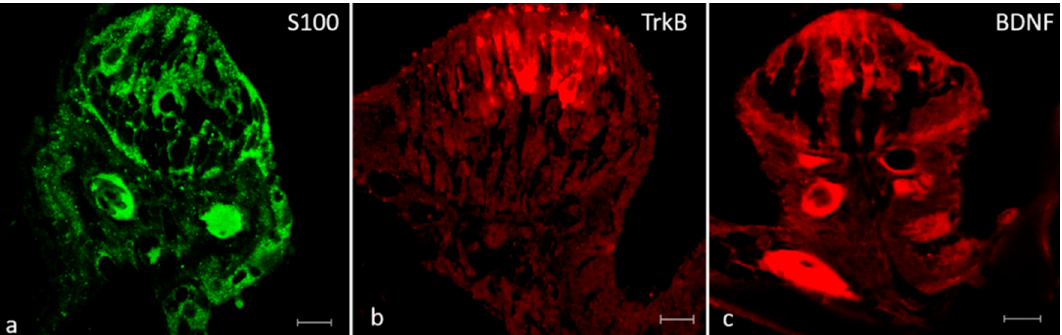
Figure 10. Inner ear of adult zebrafish. The cristae ampullaris in the apical portion contain sensory hair, supporting and basal cells. The sensory hair cells of the cristae ampullaris displayed cytoplasmic immunoreactivity for S100 protein.* ( a ), TrkB ( b ) and BDNF ( c ). Scale bars= 10 μ m. * The authors specify that the green channel was chosen to differentiate the immunofluorescence for protein S100.